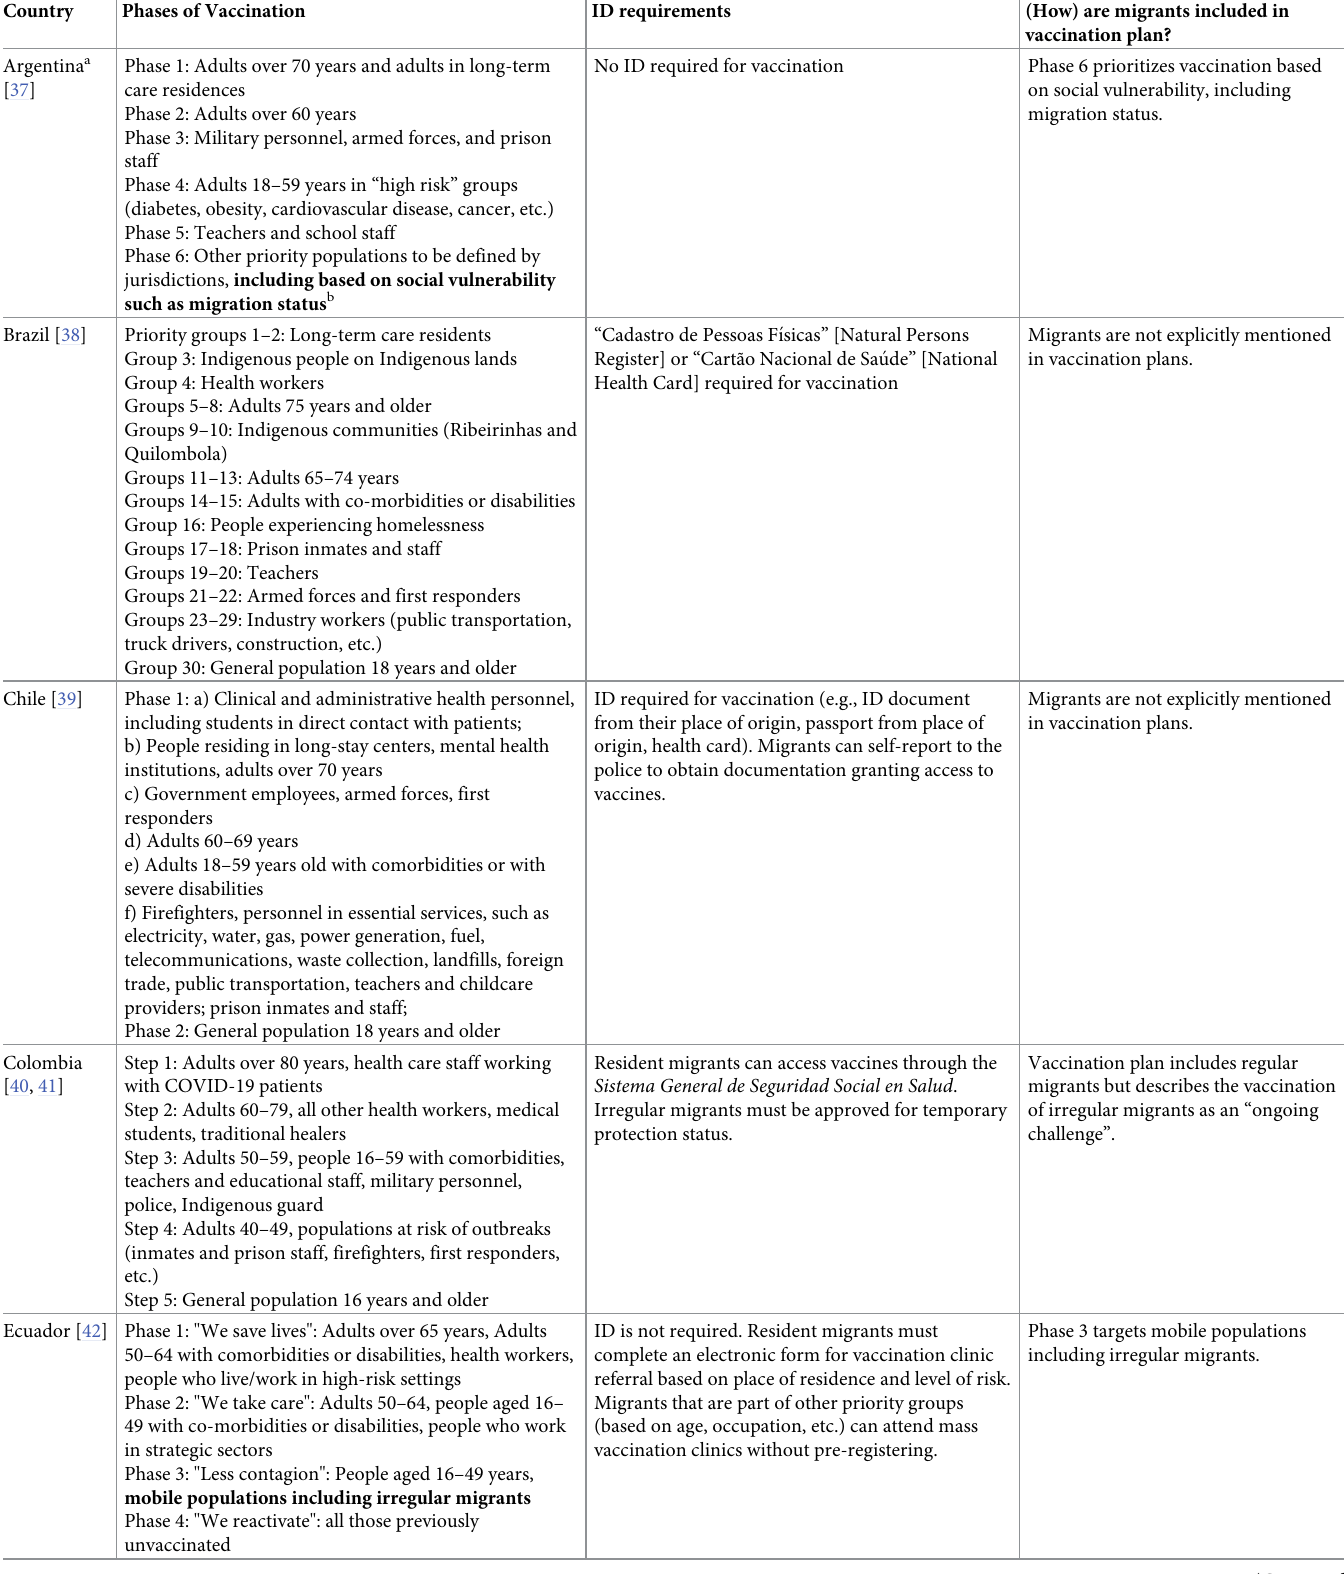
Table 1. Phases of COVID-19 vaccination, ID requirements, and inclusion of Venezuelan migrants in six host countries as of June 2021.